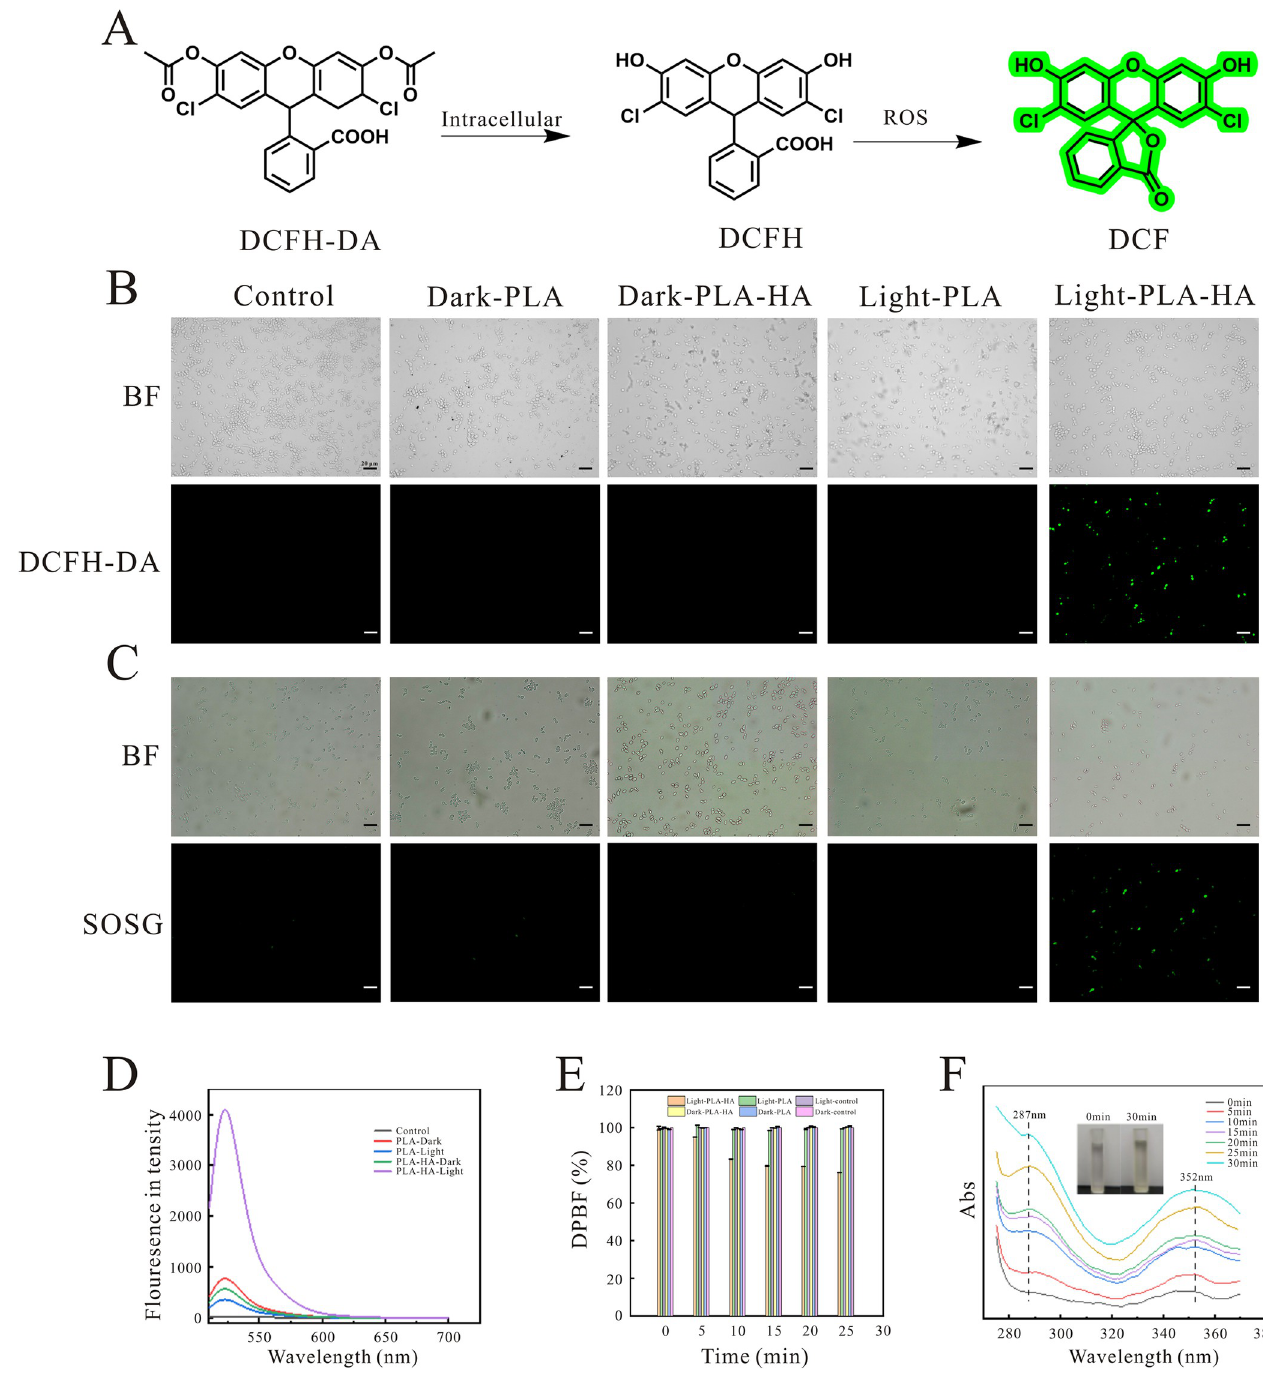
Fig 6. ROS levels of PLA-HA mediated aPDT. (A) The detected principle of intracellular ROS. (B) DCFH-DA detected by fluorescence microscopy (scale = 20 μ m). (C) Fluorescence microscopy images of SOSG-stained C . auris (scale = 20 μ m). (D) Changes in intracellular ROS levels after treatment with PLA-HA. (E) Absorbance of DPBF treated with PLA-HA. (F) UV-visible spectroscopic monitoring of the photooxidation of KI to I 3- by PLA-HA. Data are presented as the mean ± s.d.